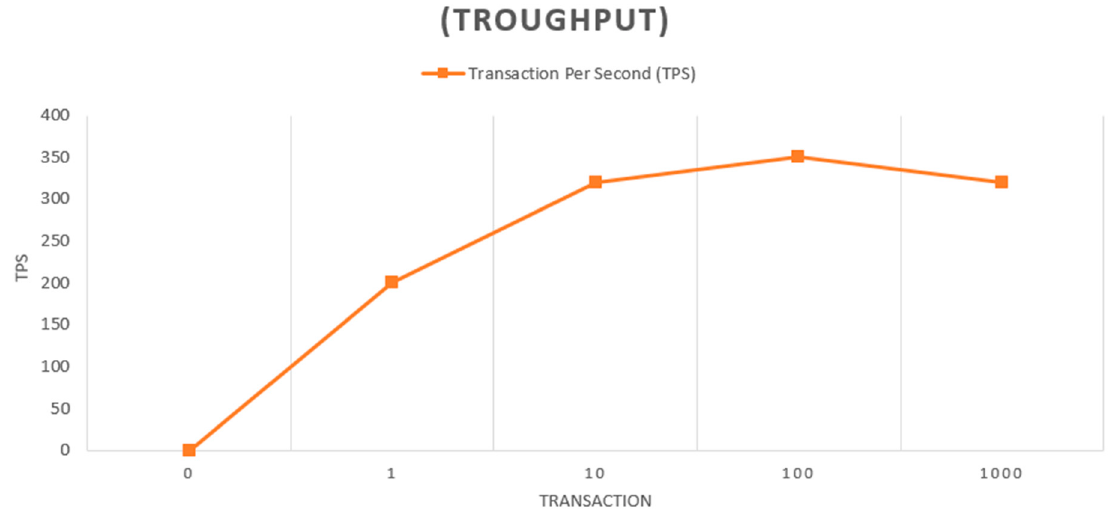
Figure 9. Throughput